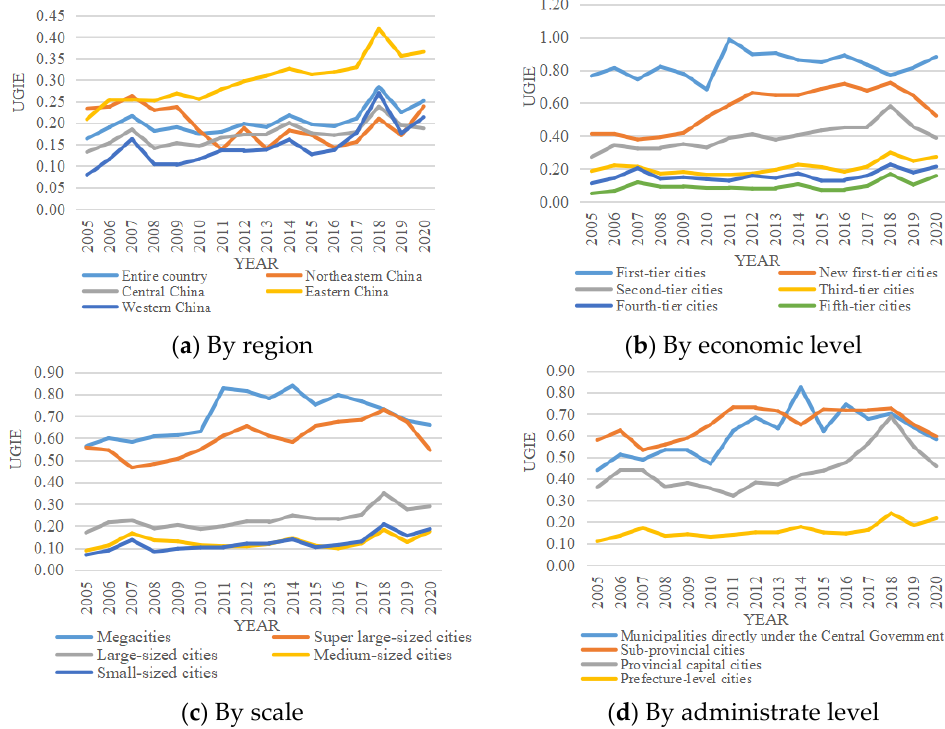
Figure 2. UGIE evolution over time in different types of cities. There are four regions in China: eastern China, central China, western China, and northeastern China (Figure 2a). The national UGIE and that of the other three regions than the northeastern China tended to rise with fluctuations. From 2005 to 2020, the national average UGIE augmented from 0.16 to 0.25, the eastern China from 0.21 to 0.37, the central China from 0.13 to 0.19, and the western China from 0.08 to 0.21. The level of the north- eastern China first dropped from 0.23 in 2005 to 0.14 in 2011 and then rose to 0.24 in 2020. As exhibited in Figure 2b, cities in China can be classified as first-tier (T1), new first- tier (NT1), second-tier (T2), third-tier (T3), fourth-tier (T4), and fifth-tier (T5) cities on the basis of their economic standing [64]. From 2005 to 2020, the UGIE in various cities was on the rise as a whole, with T1 cities from 0.76 to 0.88, NT1 cities from 0.41 to 0.52, T2 cities from 0.27 to 0.39, T3 cities from 0.19 to 0.27, T4 cities from 0.11 to 0.21, and T5 cities from 0.05 to 0.16. The UGIE of various cities over the years remained “T1 > NT1 > T2 > T3 > T4 > T5”. To put it simply, cities with higher economic levels had higher UGIE. As illustrated in Figure 2c, in accordance with size, Chinese cities can be categorized as megacities, super large-sized cities, large-sized cities, medium-sized cities, and small- sized cities [65,66]. From 2005 to 2020, the overall UGIE of large-sized cities, medium-sized cities, and small-sized cities displayed an upward trend, with large-sized cities increasing from 0.17 to 0.29, medium-sized cities from 0.09 to 0.18, and small-sized cities from 0.07 to 0.19. The UGIE of mega cities first rose from 0.56 in 2005 to 0.83 in 2011 and then dropped to 0.66 in 2020, and super large-sized cities declined with fluctuations. By administrative level, Chinese cities are divided into municipalities directly under the central government, sub-provincial cities, provincial capital cities, and prefecture-level cities (Figure 2d). From 2005 to 2020, the UGIE of the four types was all on the rise, mu- nicipalities from 0.44 to 0.58, sub-provincial cities from 0.58 to 0.60, provincial capitals from 0.36 to 0.46, and prefecture-level cities from 0.11 to 0.22. The overall UGIE of Chinese cities tended to rise, except for cities in the northeastern China, megacities, and super large-sized cities. Northeastern China may be suffering from a serious deficiency of innovation power, population loss, and economic recession owing to the large number of resource-based cities in the region. For megacities and super large-